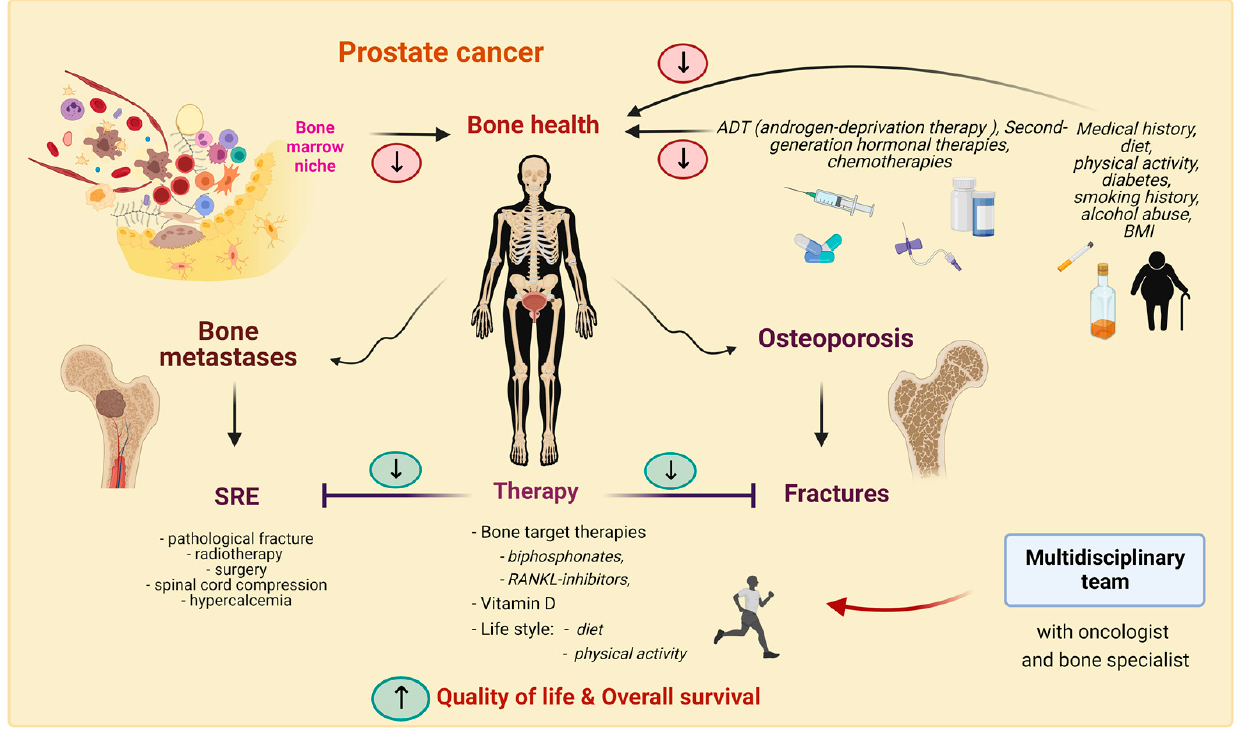
Figure 2. Possibilities and strategies for bone health in PC. The green ovals indicate interventions or factors that improve bone health, while the red ovals indicate factors that make it worse.